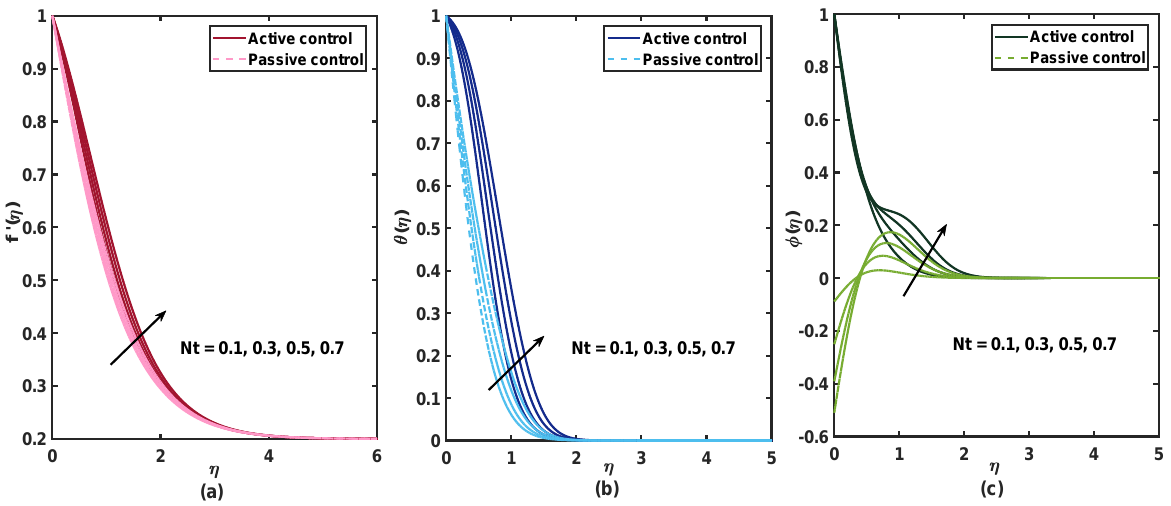
Figure 7. Impact of thermophoresis parameter Nt on ( a ) velocity, ( b ) temperature, and ( c ) nanoparticle volume fraction